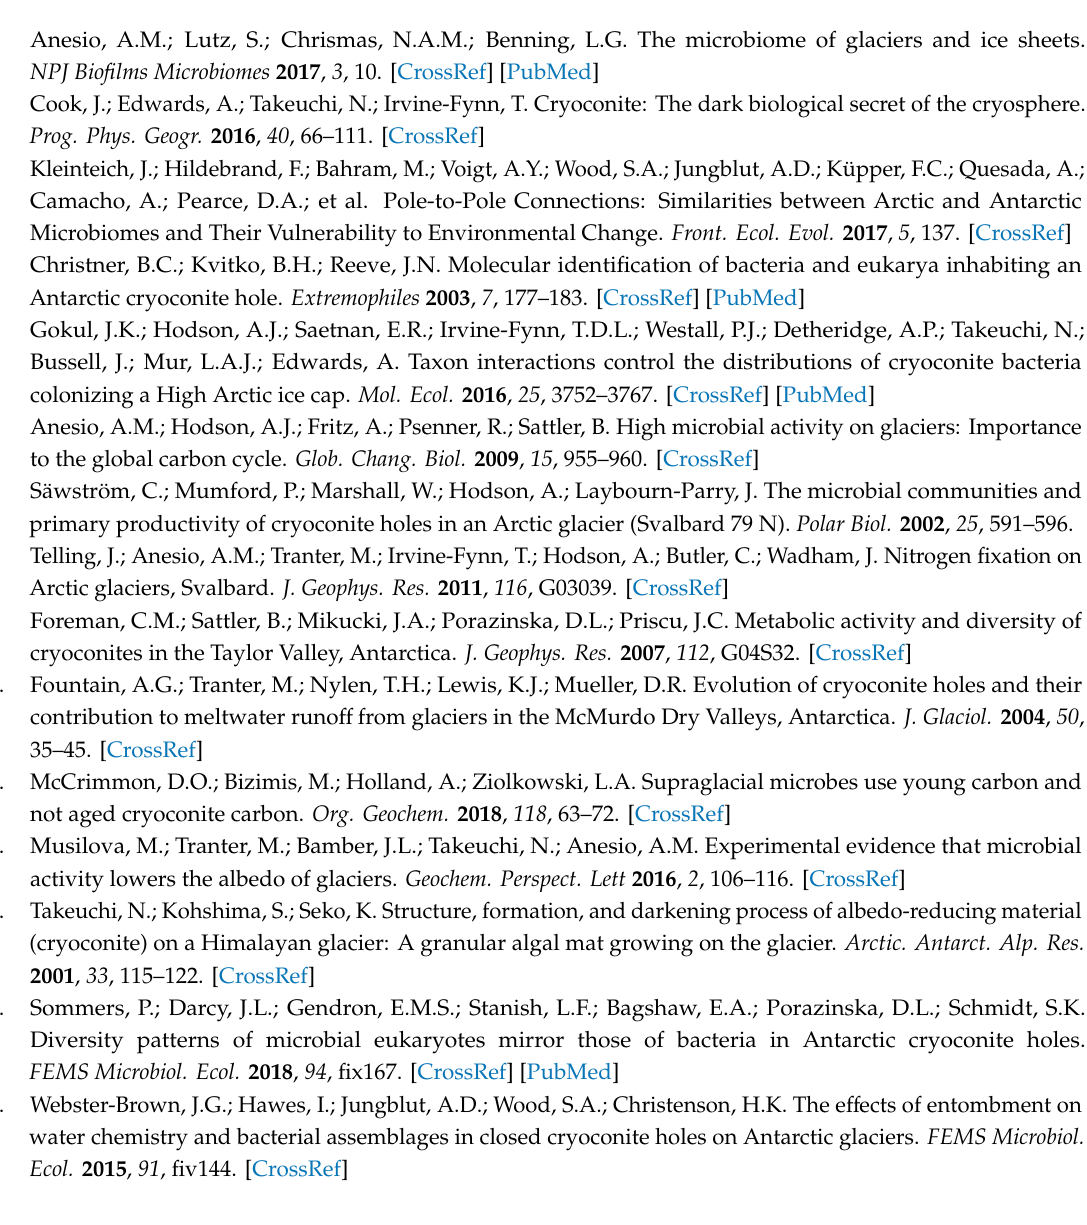
fluorescence analysis. Table S10: Aqueous concentrations of nutrients and simple organics. Data S1: Output of the PCA of bacterial OTUs. Data S2: Output of the PCA of the eukaryotic OTUs. AuthorContributions: Conceptualization, S.L., L.Z.andL.G.B.; Fundingacquisition, L.Z.andL.G.B.; Investigation, S.L. and L.Z.; Project administration, L.Z.; Visualization, S.L.; Writing – original draft, S.L.; Writing – review, editing, S.L., L.Z. and